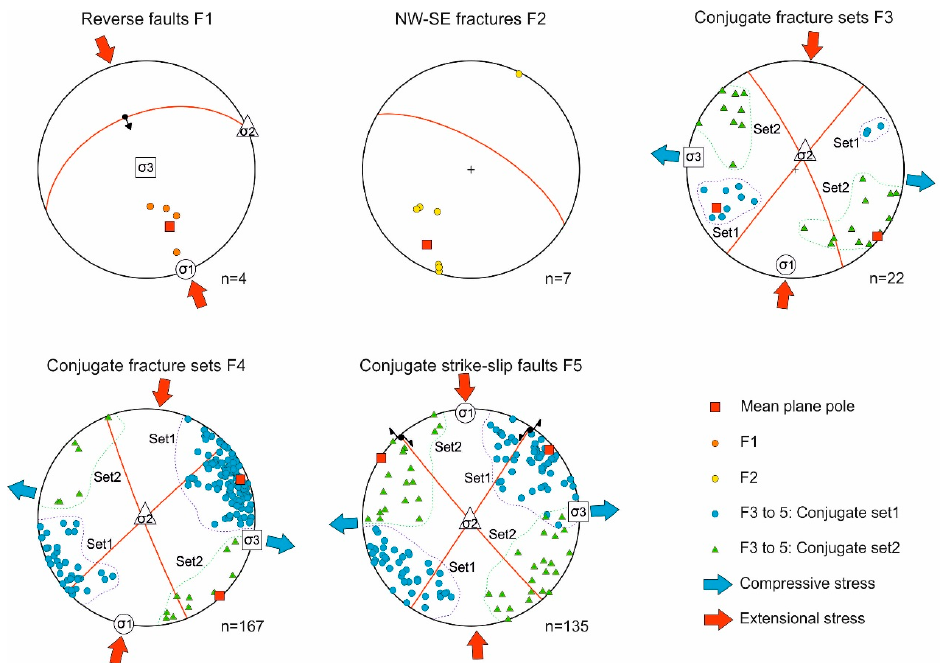
Figure 6. Lower hemisphere, equal area stereoplots of the fracture sets recognized in the frontal part of the Bóixols thrust sheet. Dots represent poles and lines represent the mean principal planes. F2 and F3 have been restored with respect to bedding.